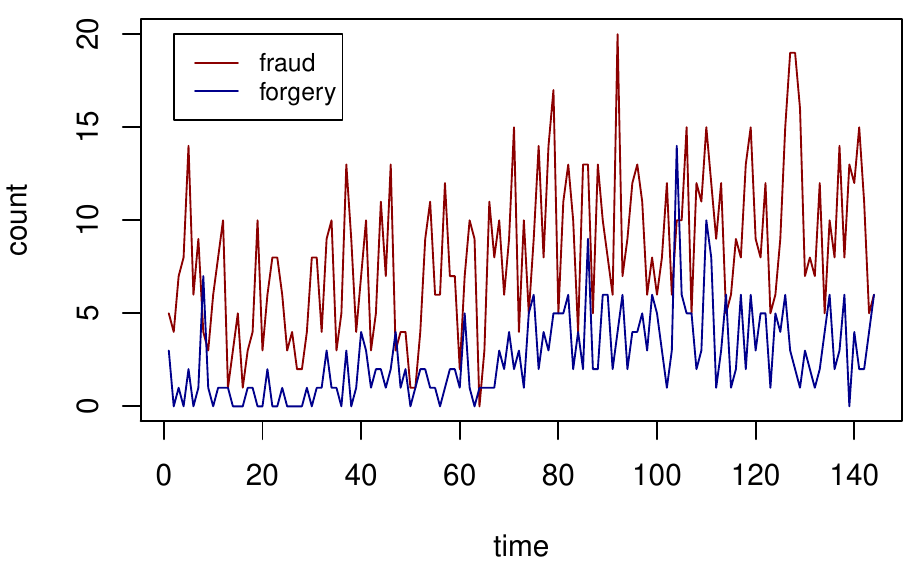
Figure 1. Forgery and fraud count series.